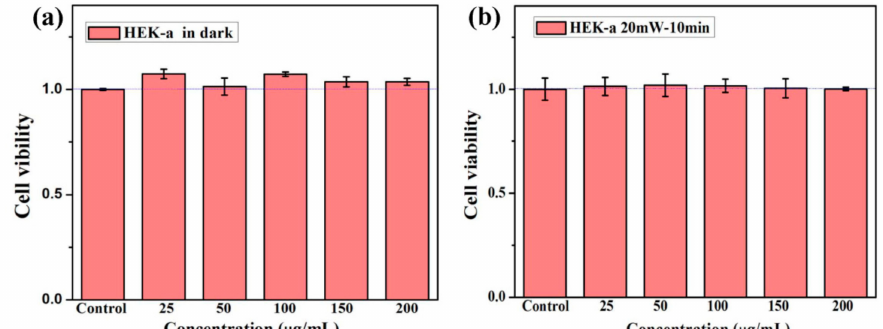
Figure 6. Cell viability of HEK-a cells incubated with di ff erent doses of C 60 -PDA-GSH nanoparticles ( a ) in the darkness for 24 h and ( b ) exposed to white light (20 mW / cm 2 ) for 30 min and then for 24 h in the darkness. The control groups were the cells treated with